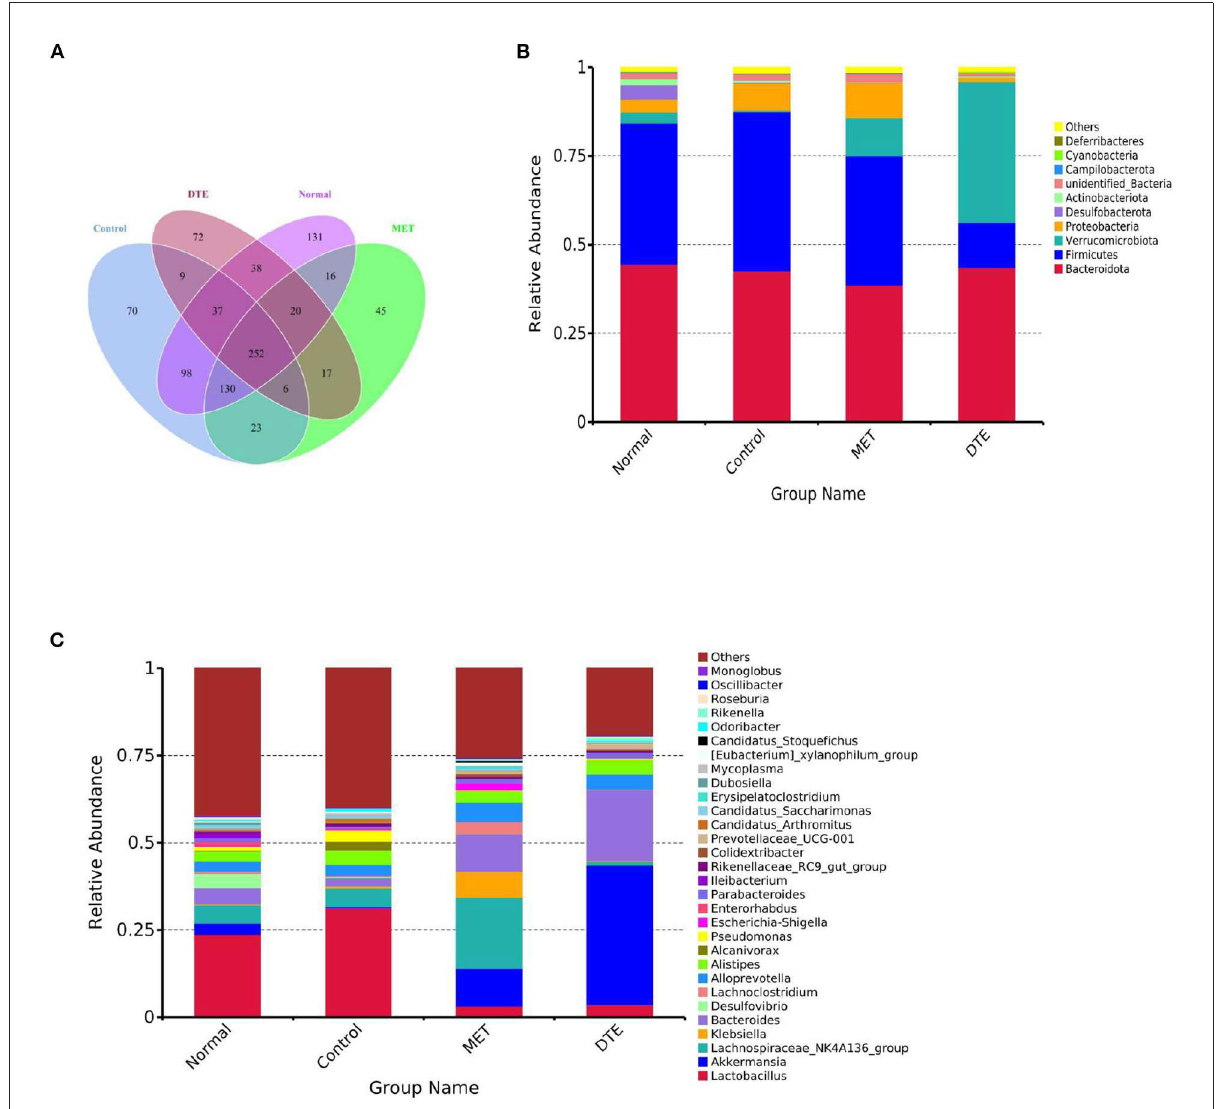
FIGURE9 Effect of DTE on intestinal microbial community of diabetic mice. (A) Venn diagram based on OTU; (B) Effect of DTE on intestinal microbial community of diabetic mice at phylum species level; (C) Effect of DTE on intestinal microbial community of diabetic mice at genus